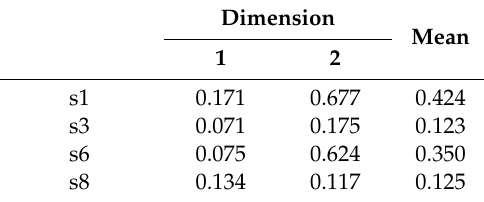
Table 6. Discrimination measures for